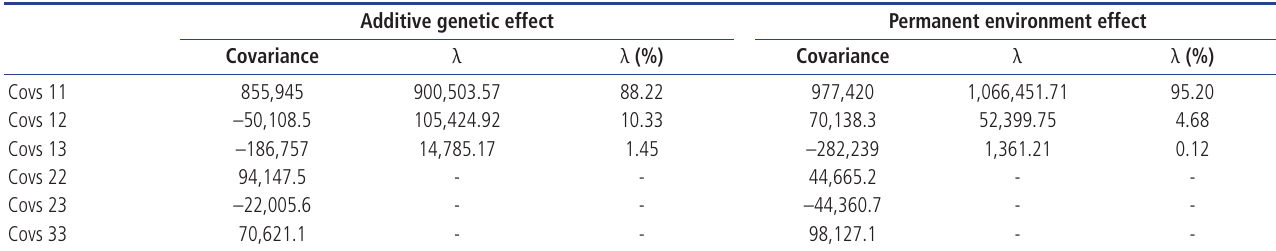
Table 4. Covariance matrix of random regression coefficients for additive genetic and permanent environmental effects with eigenvalues ( λ ) obtained with the best model (LE33het10) in dataset